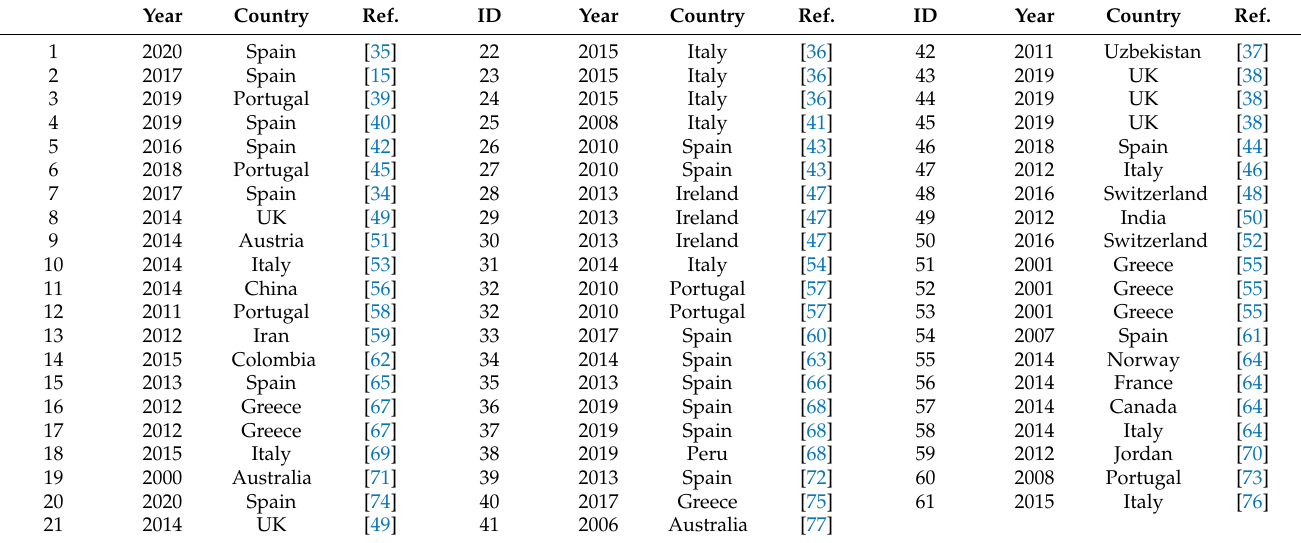
Table 1. Information of the studies